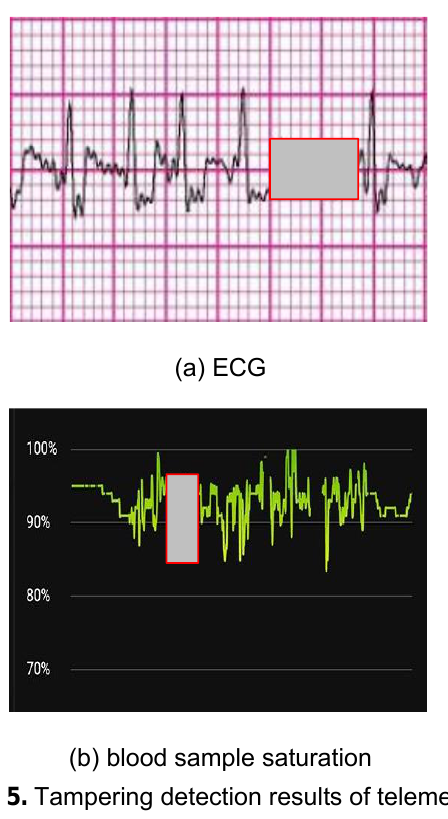
Figure 5. Tampering detection results of telemedicine video area